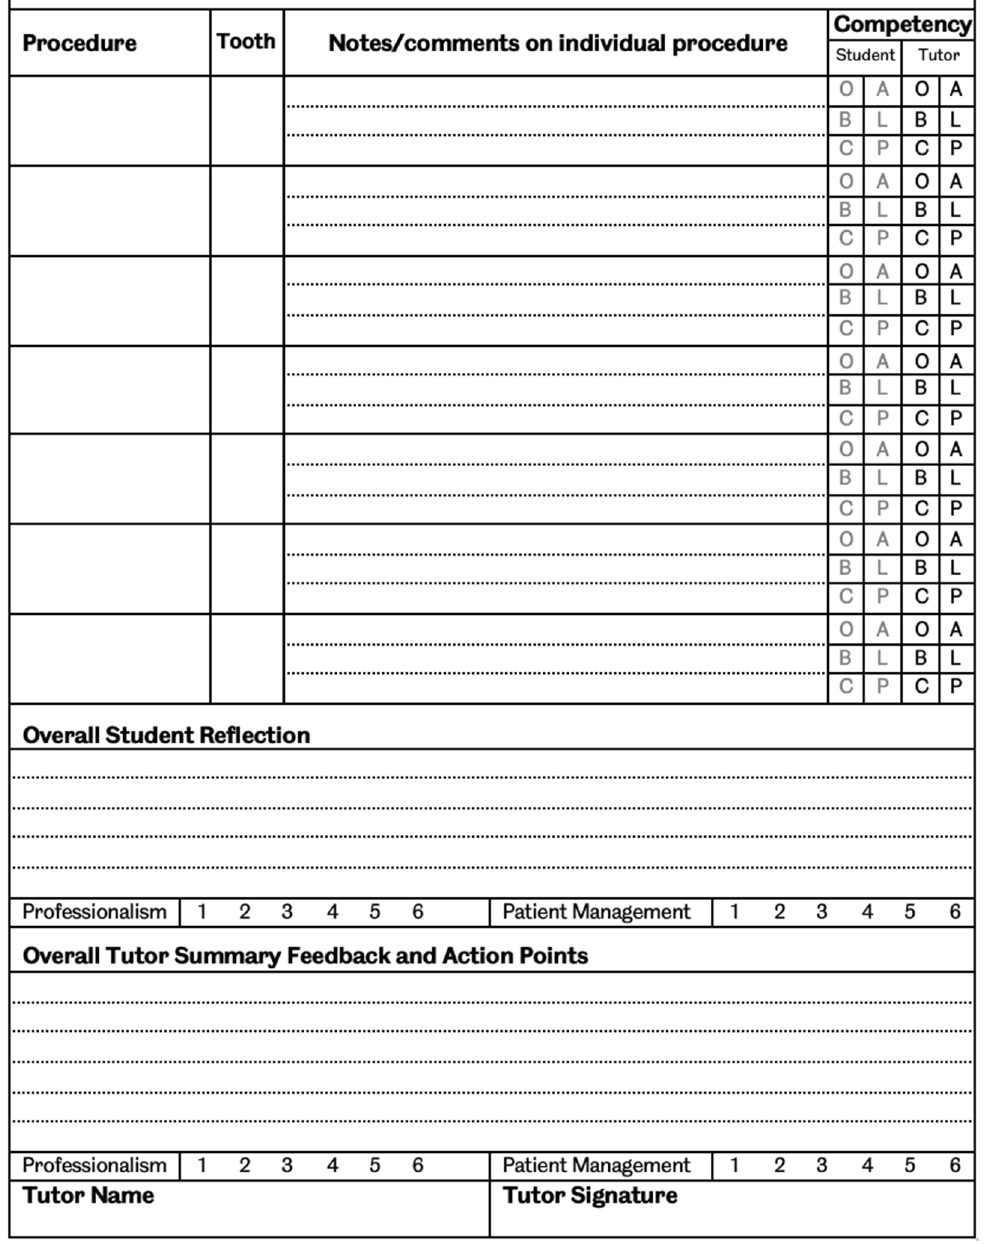
Figure 1. Sample page from the student logbook showing the unstructured space for reflection. CSLE—Clinical Skills Learning Environment, O—Observed, A—Assisted, B—Beginner, L—Learner, C—Competent, P—Proficient.